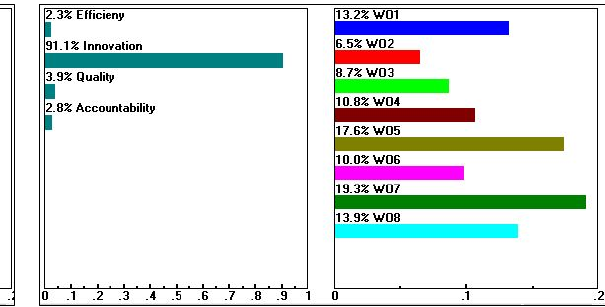
Fig. 7. The dynamic sensitivity for the efficiency criteria from the initial weight of 0.204 (20%) to 0.911 (91.1%)